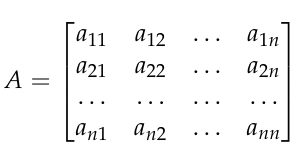
Table 2. Saaty’s importance scale. Definition Assigned Value Equally important 1 Weak importance 3 Strong importance 5 Demonstrated importance 7 Absolute importance 9 Intermediate values 2, 4, 6,